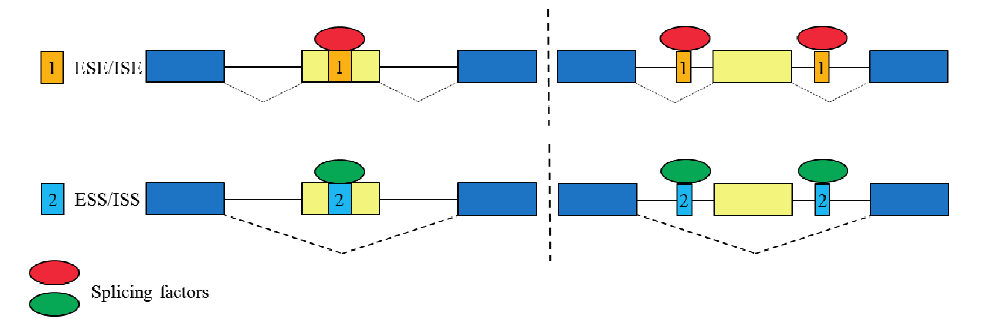
Figure 1. Regulation of alternative splicing events by the interplay between trans -splicing factors and cis- regulatory elements within pre-mRNAs. Square 1 represents ESE (exonic splicing enhancer) or ISE (intronic splicing enhancer); square 2 represents ESS (exonic splicing silencer) or ISS (intronic splicing silencer); dotted line is applied to separate the exonic or intronic regulatory elements; blue rectangles represent the conserved exons; yellow rectangles represent the regulated exons; red and green ovals represent different splicing